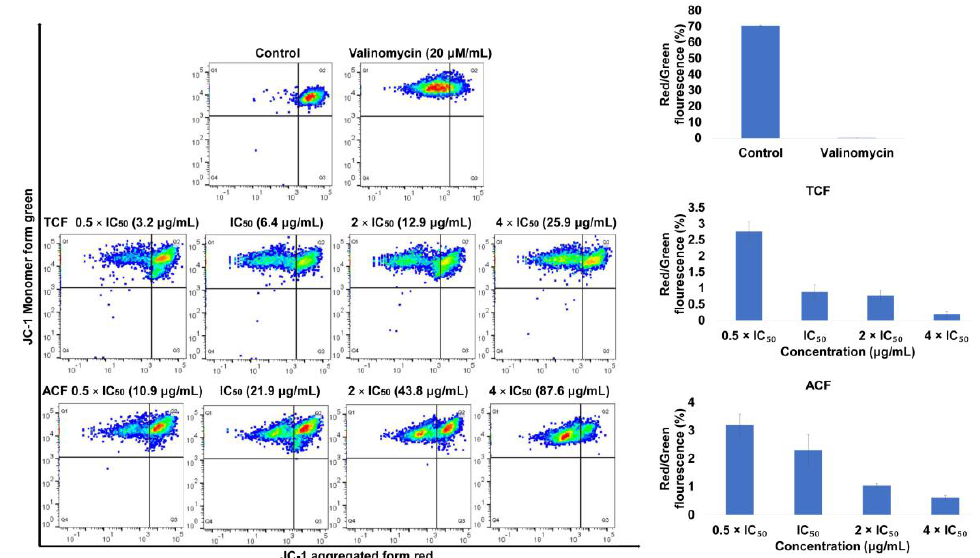
Figure 4. Disruption of mitochondrial membrane potential (MMP) in NCI-H929 cells exposed to 0.5, 1, 2, 4 × IC 50 of chloroform fractions of T. vulgaris (TCF) and A. lappa (ACF) for 24 h, stained with 5,5′,6,6′-tetrachloro-1,1′,3,3′-tetraethylbenzimidazolyl carbocyanine iodide (JC-1) and analyzed by cytometry. The ratio of red (JC-1 aggregate) / green (JC-1 monomer) fluorescence was used to display the e ff ect of TCF, ACF, and valinomycin on the MMP integrity. Control: NCI-H929 cell without